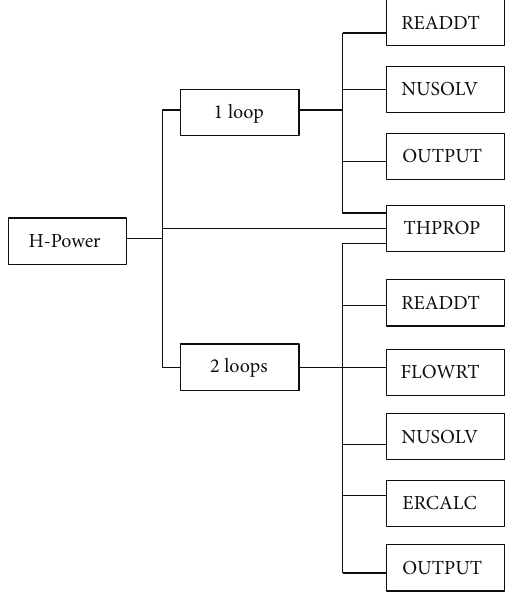
Figure 1: H-Power modules